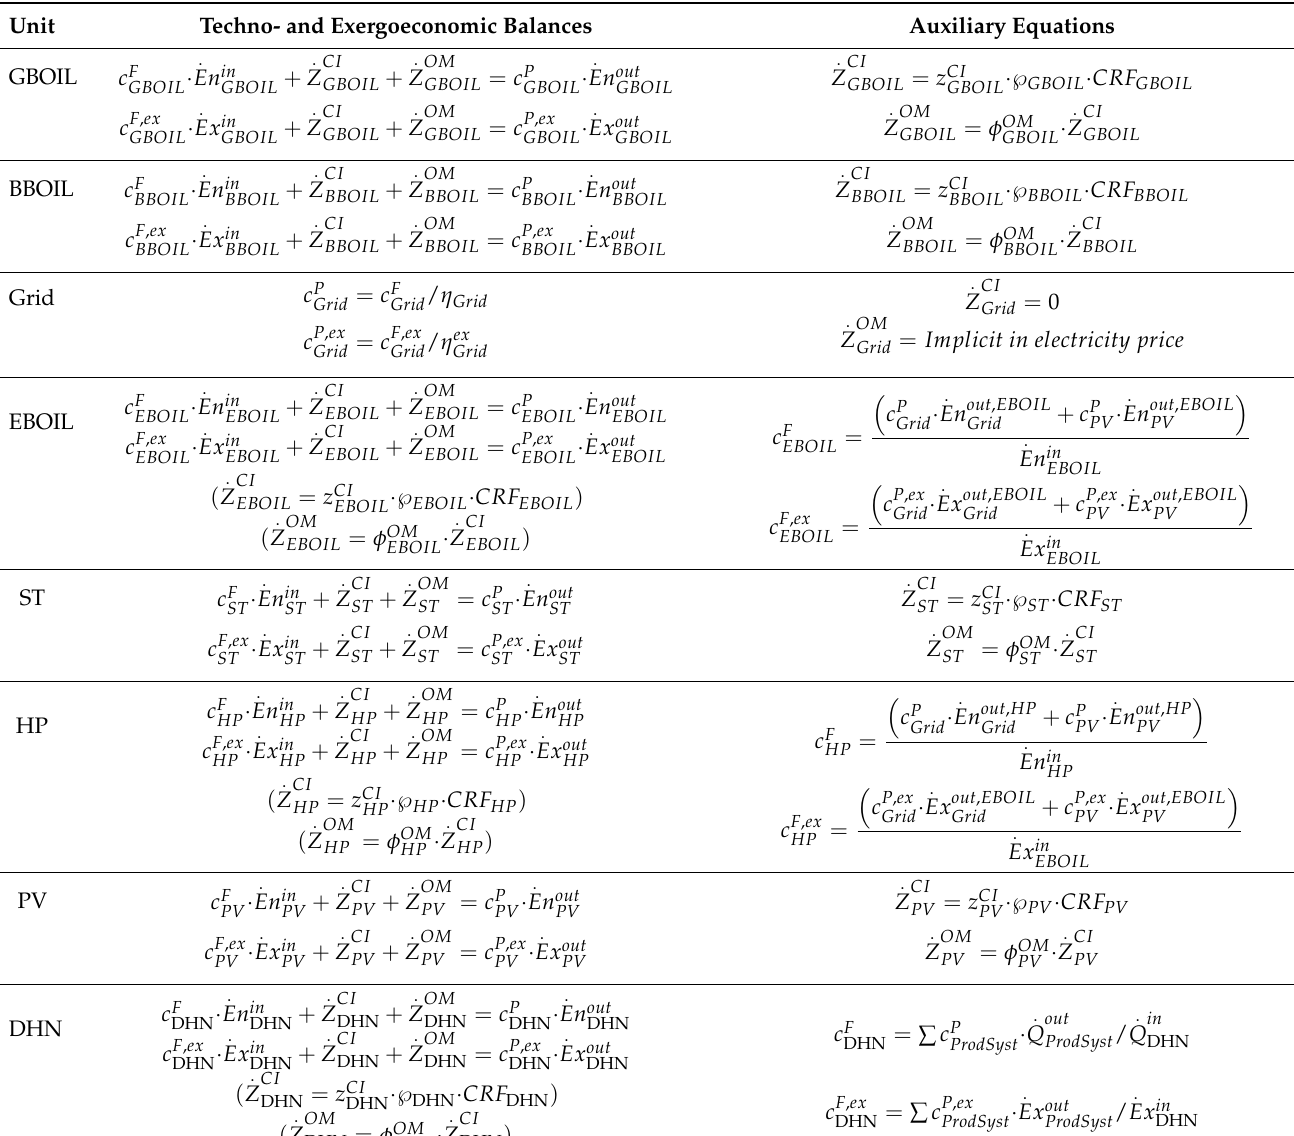
Table A4. Unit-by-unit formulation of technoeconomic and exergoeconomic balances and auxiliary equations. Unit Techno- and Exergoeconomic Balances Auxiliary